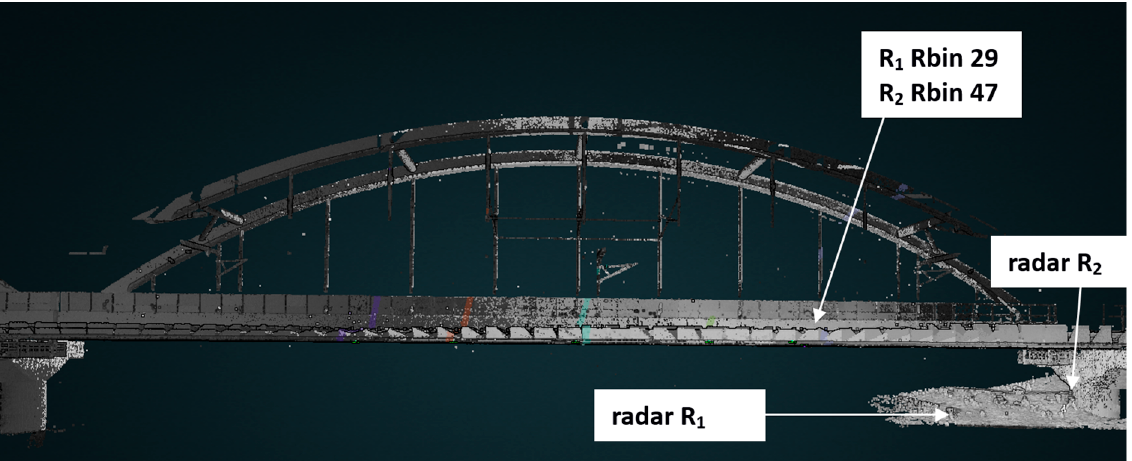
Figure 21. Three-dimensional model of the bridge with color-highlighted Rbins for radars R1 and R2, which were evaluated, and with marked positions of both radars below the structure BS2.